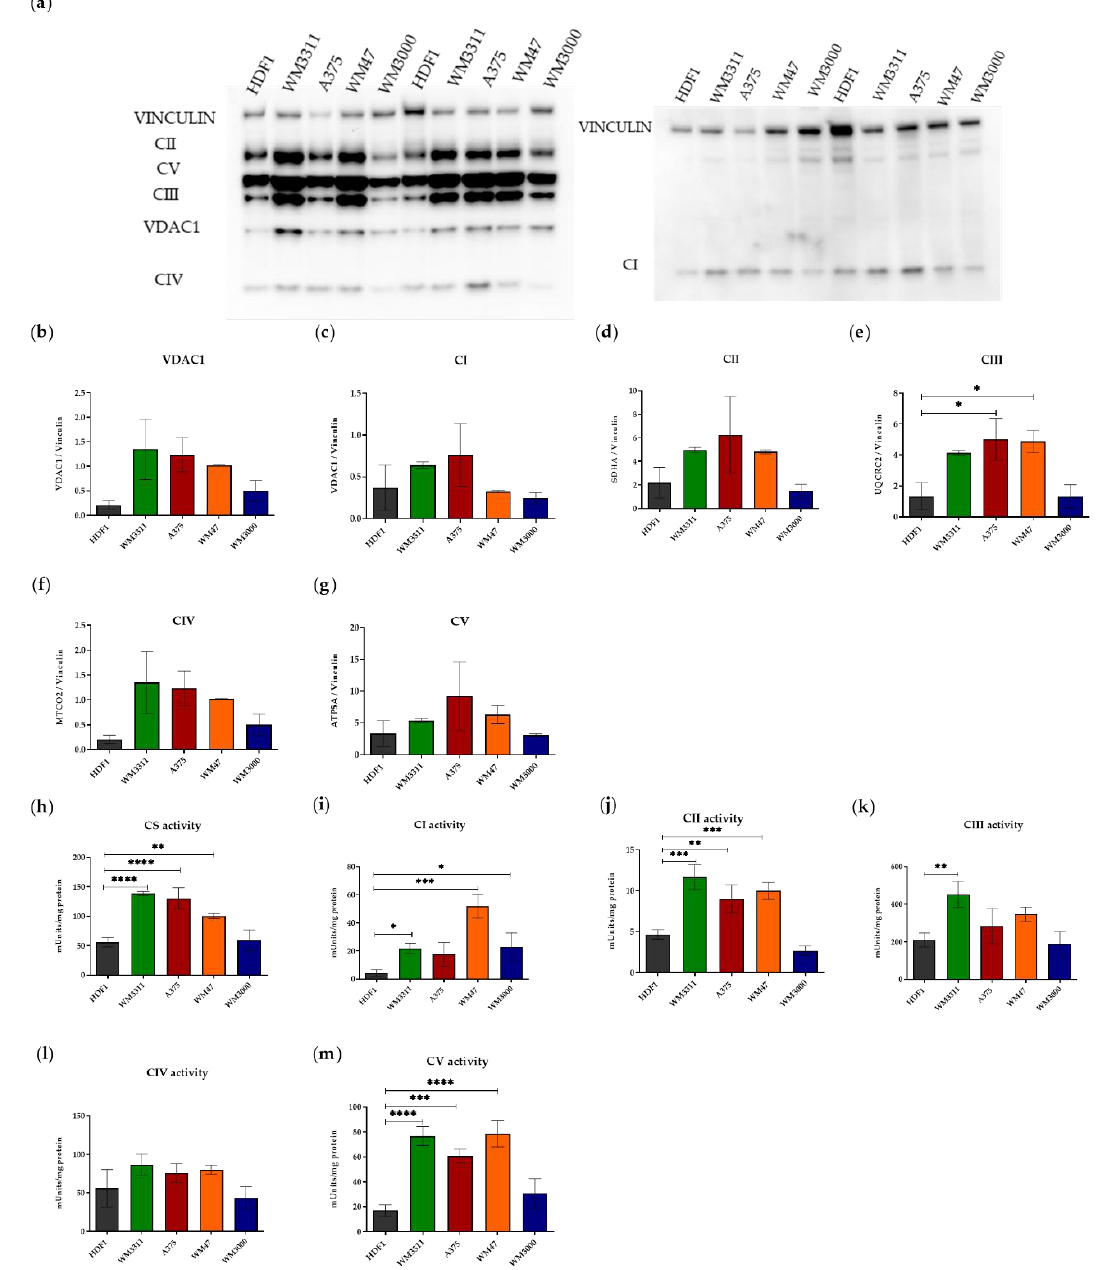
Figure 1. Melanoma cell lines show higher levels of OXPHOS compared to HDFs. ( a ) The left and right panels represent two separate western blots because of the equal size of the MTCO2 (CIV) and the NDUFS4 (CI) protein. ( b – g ) Western blot analysis for subunits of OXPHOS complexes (CI-CV), VDAC1 and vinculin in HDF1, WM3311, A375, WM47 and WM3000 cells. ( h – m ) Absolute activities of citrate synthase and OXPHOS complexes in HDF1, WM3311, A375, WM47 and WM3000 cells. Values are given as mean ± SD. One-way ANOVA followed by Dunnett’s Multiple Comparison Test; * p ≤ 0.05; ** p ≤ 0.01; *** p ≤ 0.001; **** p ≤ 0.0001. For western blot and enzymatic activity: post-nuclear supernatant containing the mitochondrial fraction was used. Two and three independent experiments were performed for western blot (n = 2) and enzymatic activity (n = 3), respectively. The levels of OXPHOS complexes and VDAC1 were normalized to vinculin. The activities of the OXPHOS complexes were normalized to protein concentration in cell lysates. Citrate synthase (CS); Complex I (CI); Complex II (CII); Complex III (CIII); Complex IV (CIV); Complex V (CV).